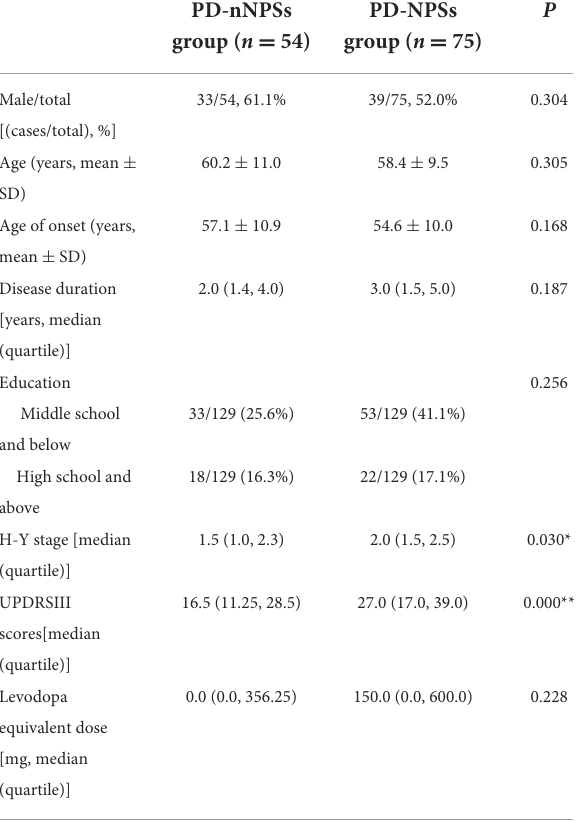
TABLE 3 Comparisons of the levels of free radicals and neuroinflammatory factors, and the activity of tSOD in CSF between PD-NPSs and PD-nNPSs